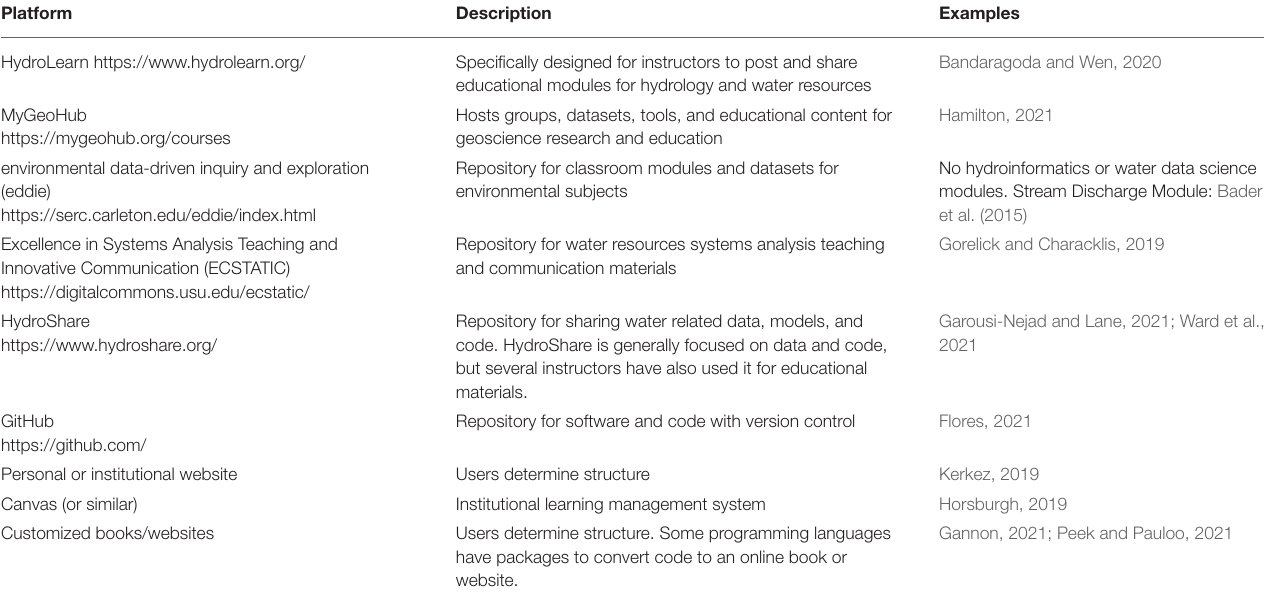
TABLE 3 | Educational platforms and instances of hydroinformatics or related implementations.